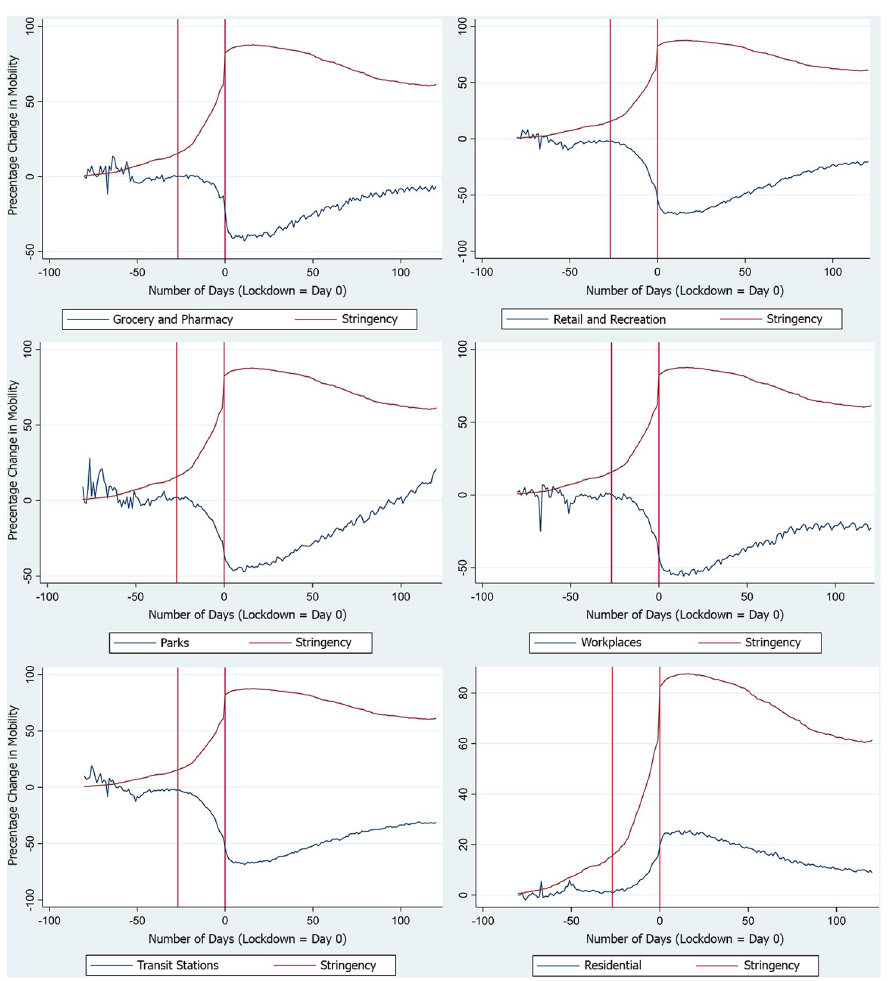
Fig 1. Event study of days since country lockdown(= 0) and mobility measures. Event study of 107 countries with national lockdown. Percentage change in mobility is in reference to the median value of mobility for the corresponding day of the week during the 5 weeks of January 3, 2020, to February 6, 2020. Day = 0 represents the day of national lockdown in the home country. The red line to the left of Day = 0 represents the average number of days prior to lockdown when the date of national lockdown was